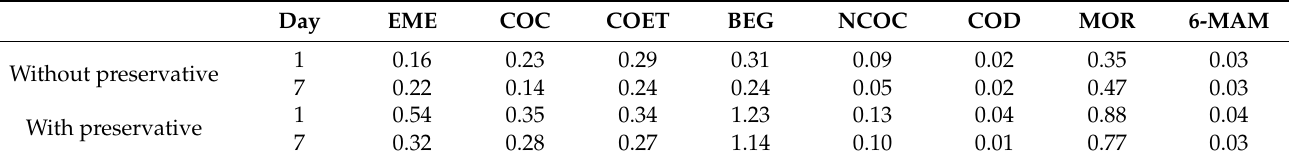
Table 3. Response of analytes with and without preservative after 1 and 7 days of storage under ideal